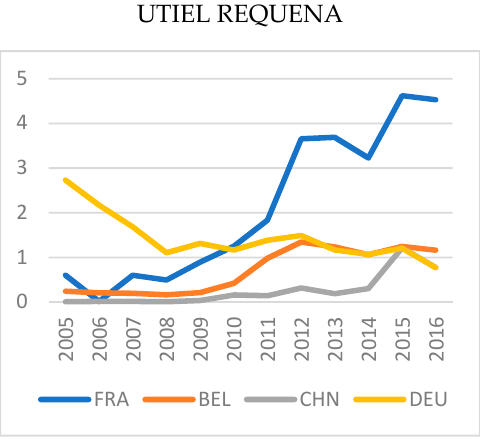
Figure 2. Evolution of CO 2 emissions generated by Spanish wine exports from each DO in relation to the most significant importing countries.